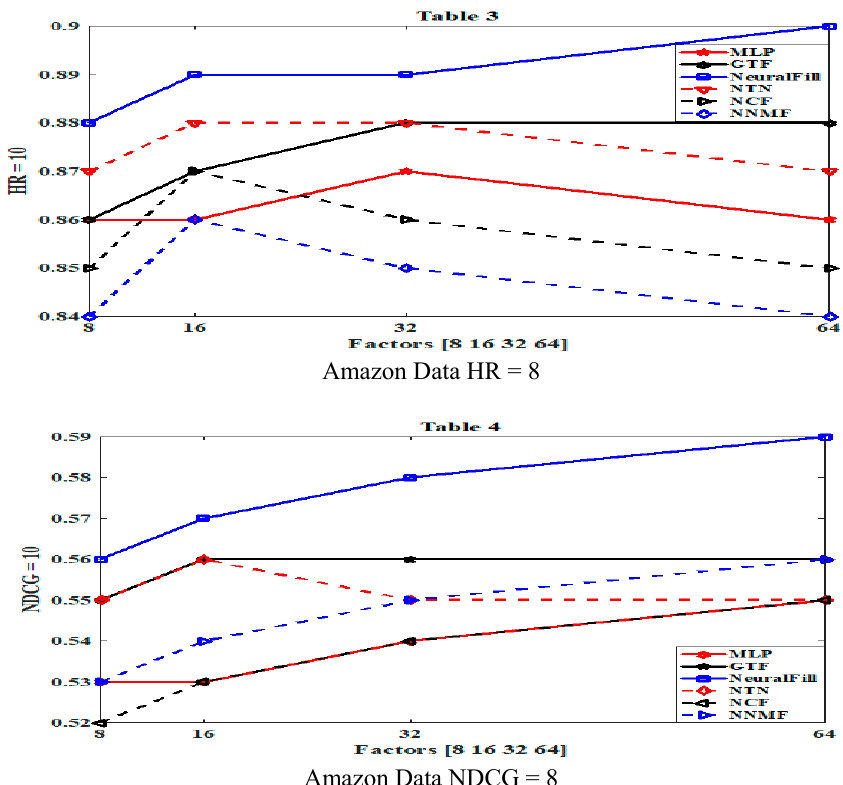
Figure 3. Performance of NDCG and HR with their respective predictive factors on the datasets .